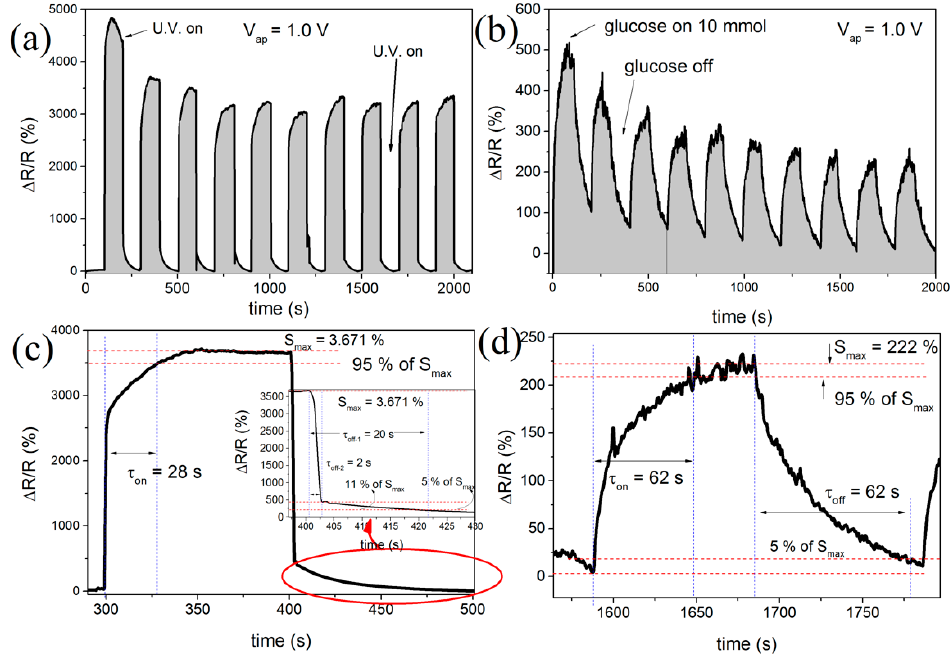
Figure 4. Sensors results to ( a , b ) sensibility UV, photoresponse characteristics and GLU sensor based on SnO 2 nanowire, respectively. In ( c , d ) the response time graphs for both UV and GLU sensors are shown.